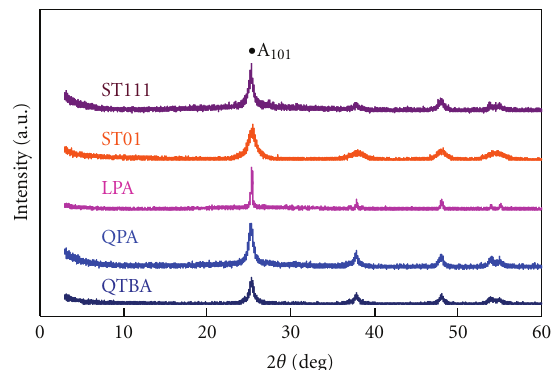
Figure 1: XRD patterns of the self-prepared (QTBA, QPA, and LPA) and the commercial (ST01 and ST111) TiO 2 nanocrystal samples. These samples are single phase of anatase. The width of di ff raction peaks indicates the crystallinity increasing order of ST01 < ST111 < QTBA < QPA <